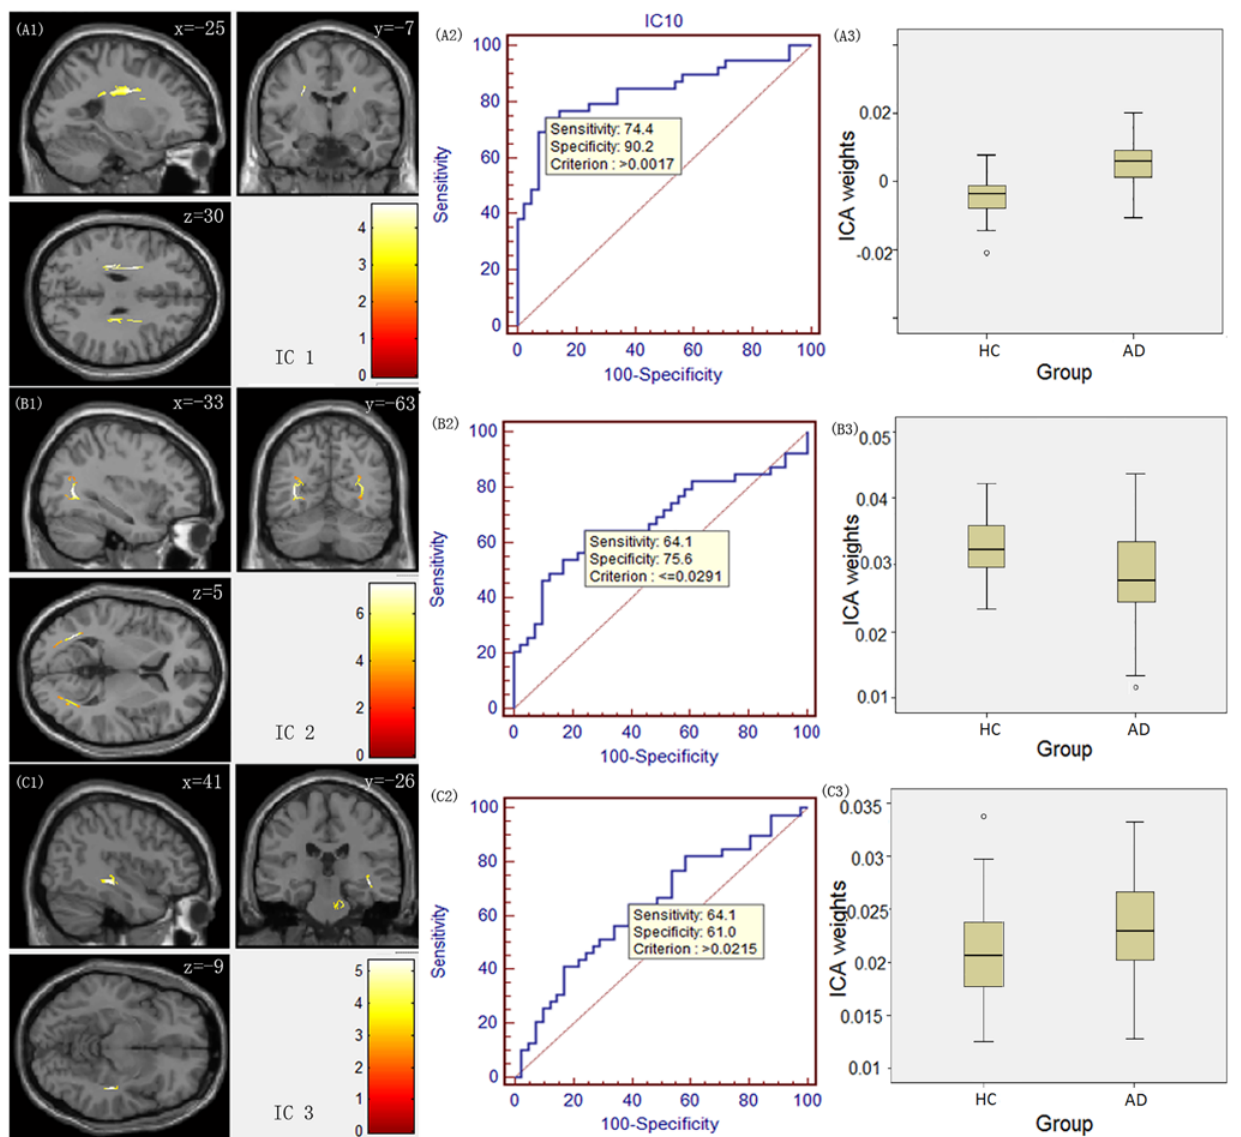
Fig 1. IC spatial maps displaying the covariant FA changes in white matter in AD patients compared to HCs for ICs 1 – 3. The colour bar represents Z- score. The middle panel displays their corresponding receiver operating characteristic (ROC) curves, and the right panel displays a boxplot of the between- group differences in ICA